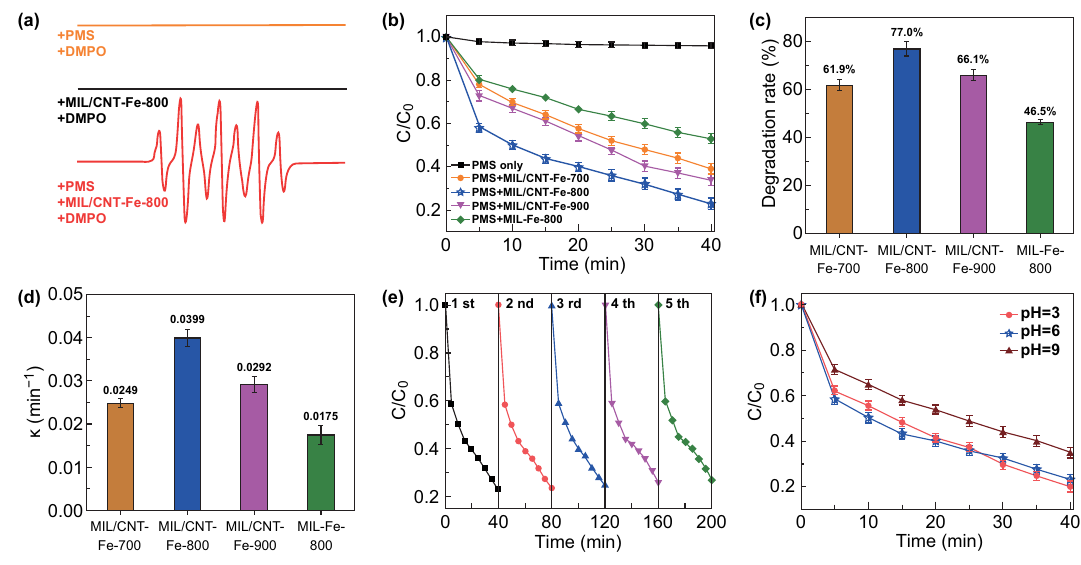
Fig. 4 a EPR measurements with/without MIL/CNT–Fe-800. b Degradation curves of BPA in different reaction systems. c Degradation rates (%) of BPA with different catalysts in 40 min. d The reaction rate constants of BPA degradation in different reaction systems. e Recycling experiments for BPA degradation using MIL/CNT–Fe-800. f Contrast experiment at solution with different pH values for BPA degradation using MIL/CNT–Fe-800. Reaction conditions: [BPA] = 20 mg L −1 , [PMS] = 0.2 g L −1 , catalyst = 0.1 g L −1 , T = 298 K, initial pH =